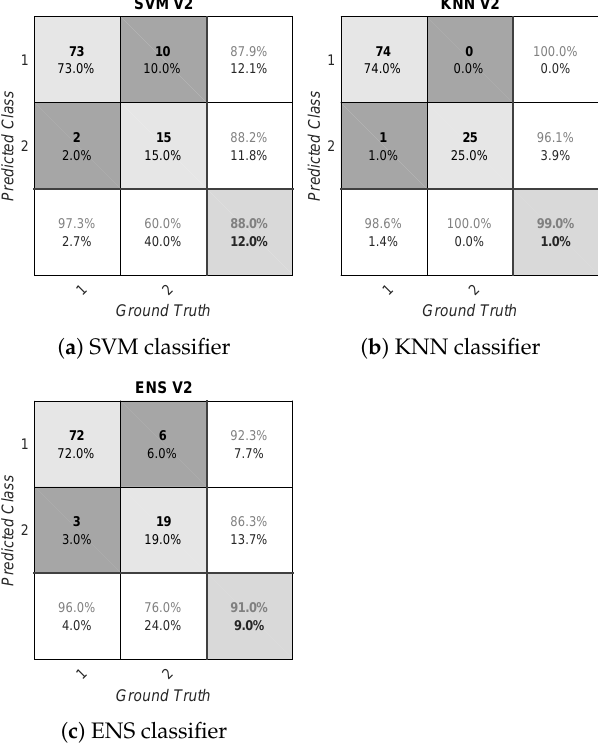
Figure A2. Confusion matrices for a subject-dependent model for